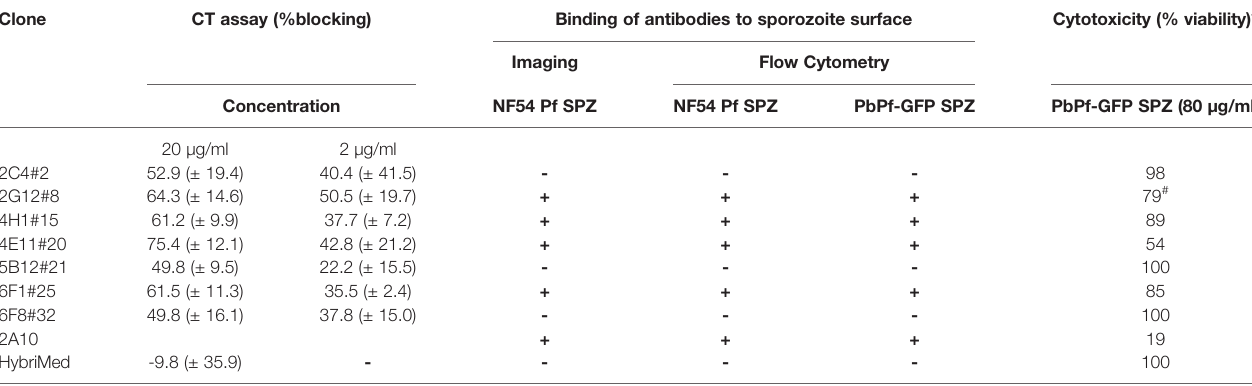
TABLE 2 | Summary of anti- Pf CSP mAb activity in sporozoite cell traversal (CT) assays. Clone CT assay (%blocking) Binding of antibodies to sporozoite surface Cytotoxicity (% viability)* Imaging Flow Cytometry